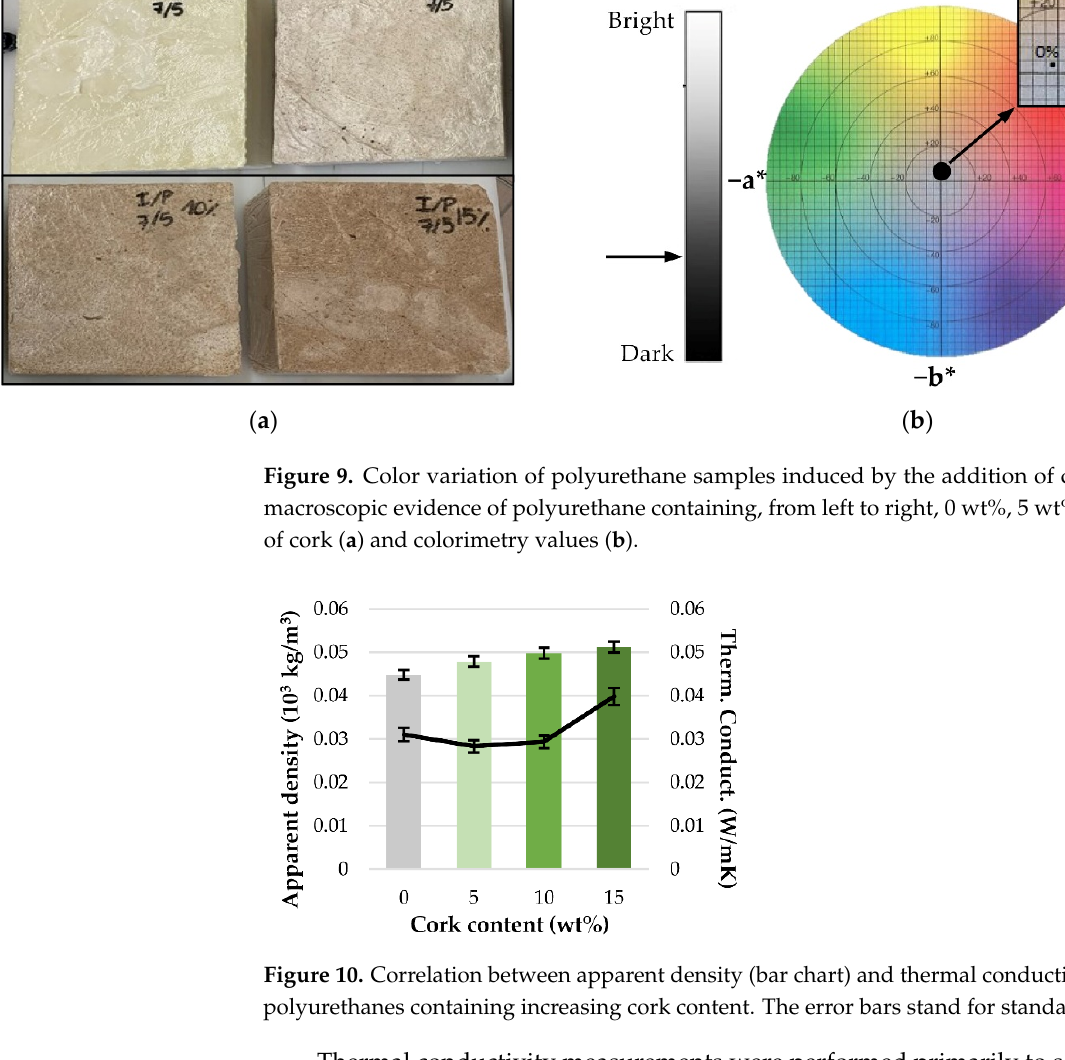
Figure 9. Color variation of polyurethane samples induced by the addition of cork waste: visual macroscopic evidence of polyurethane containing, from left to right, 0 wt%, 5 wt%, 10 wt%, 15 wt% of cork ( a ) and colorimetry values ( b ). Table 4. Colorimetry test results for polyurethanes.